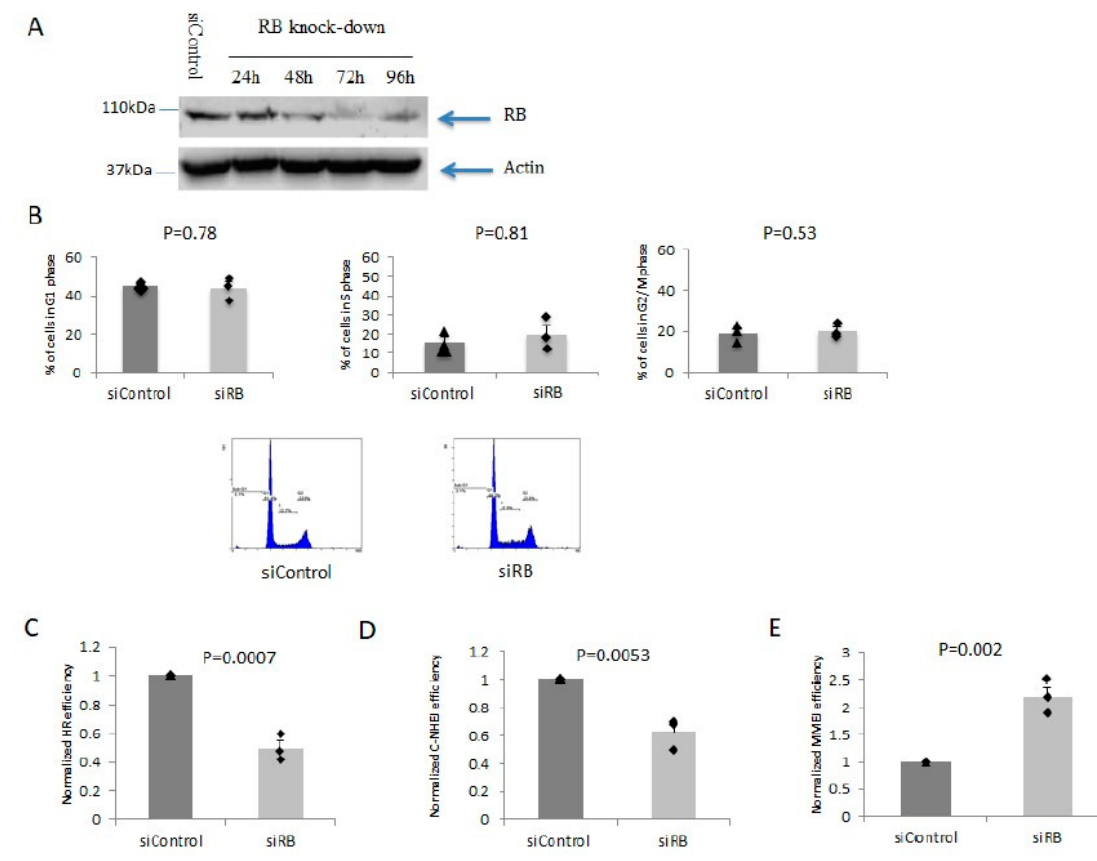
Figure 1. RB knocked-down cells repair double strand breaks (DSBs) mainly by the micro-homology mediated end joining (MMEJ) pathway. ( A ): RB was knocked down by siRNA treatment. ( B ): Cell cycle distribution in both RB knocked-down cells and the control treated cells. Representative cell cycle profiles are shown from one of the triplicate experiments. ( C ): Homologous recombination (HR) efficiency was measured by the DRGFP reporter assay. ( D ): C-NHEJ efficiency was measured by the EJ5GFP reporter assay. ( E ): MMEJ efficiency was measured by the EJ2GFP reporter assay. All experiments were repeated three times. Bar charts show the mean values from three experiments. Error bars show the standard error of the mean. Unpaired T-test was used for statistical analysis.